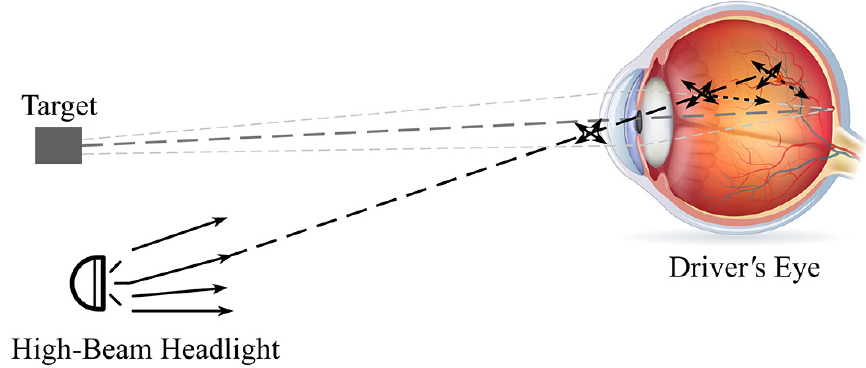
Figure 1. Light scatter in the eye due to high-beam headlight glare.